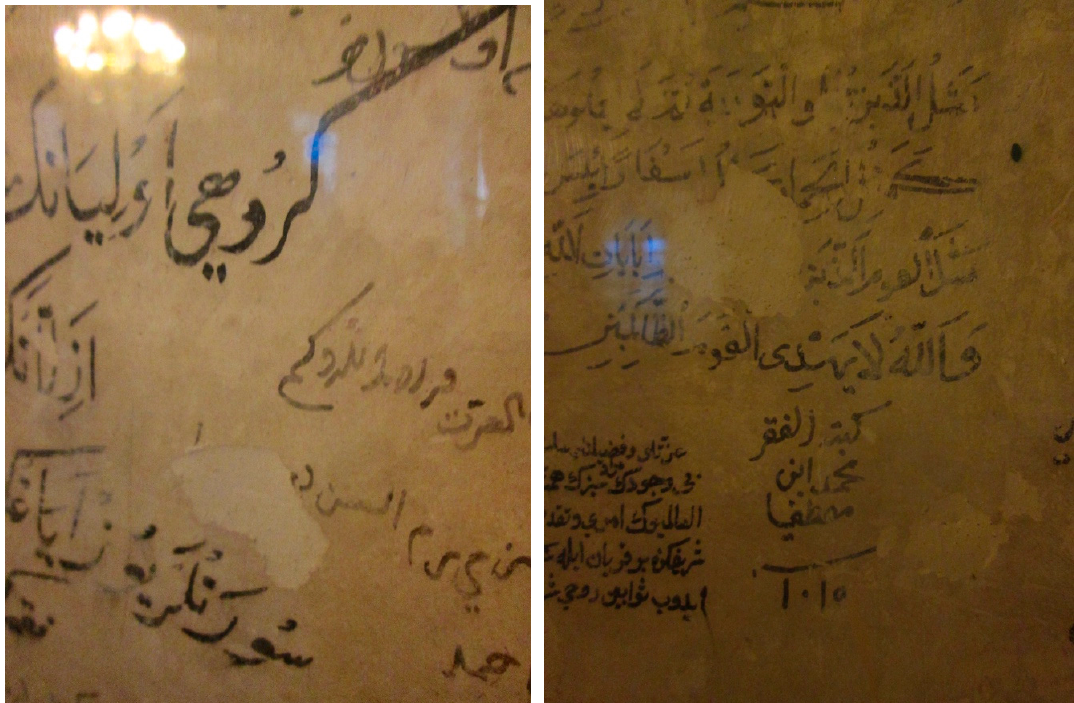
Figure 1. Examples of the wall-writing in the shrine of Ya ḥ ā Efendi, here showing examples in both Arabic and Ottoman Turkish, compositions both original and reproducing other texts, particularly the Qur’an. One of the inscriptions, in the left photo, is dated AH 1015/1606-7. Photos by the author. Were you to go back in time to eighteenth century Be¸sikta¸s to visit the shrine of Yah. y¯a